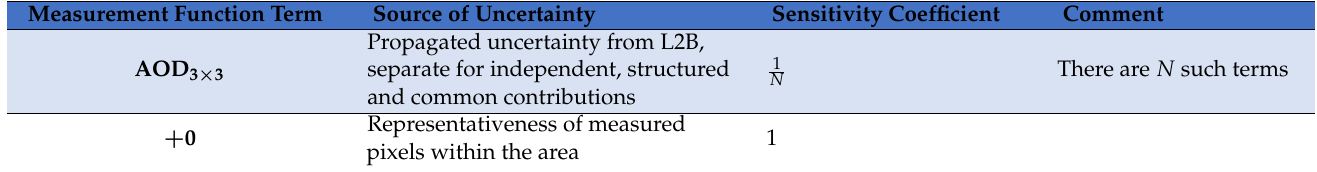
Table 8. Sources of uncertainty.